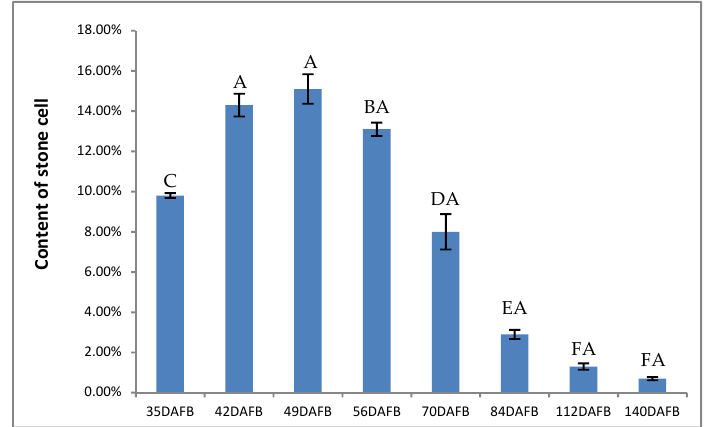
Figure 5. Content of stone cells during pear development. Different big letters indicate significant difference at 0.01 level.